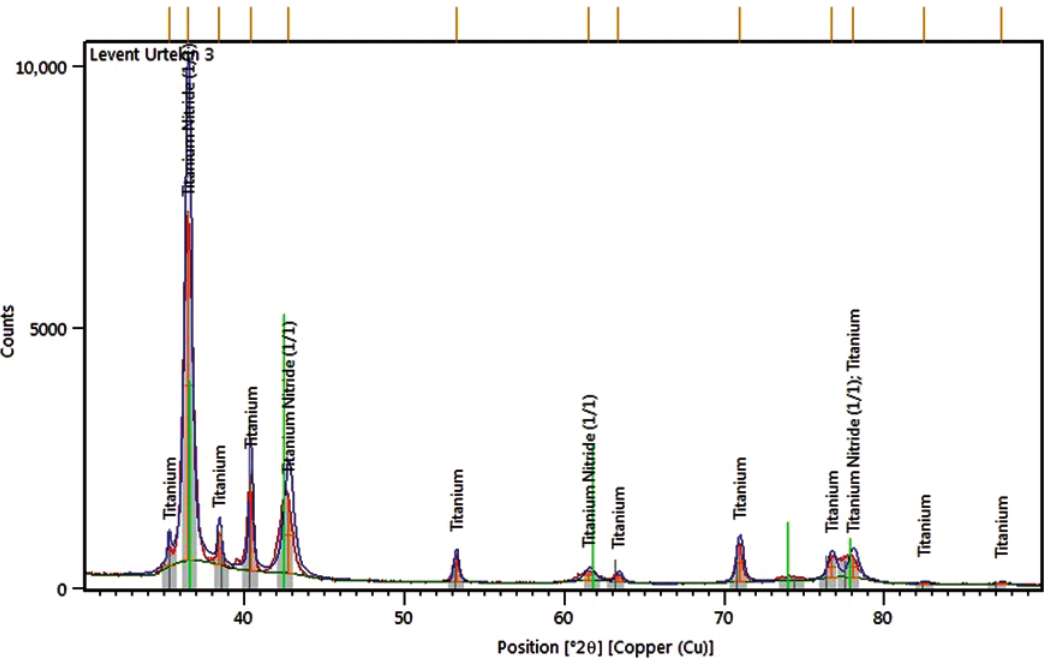
Figure 2 Ti-6Al-4V/TiN composite coating XRD